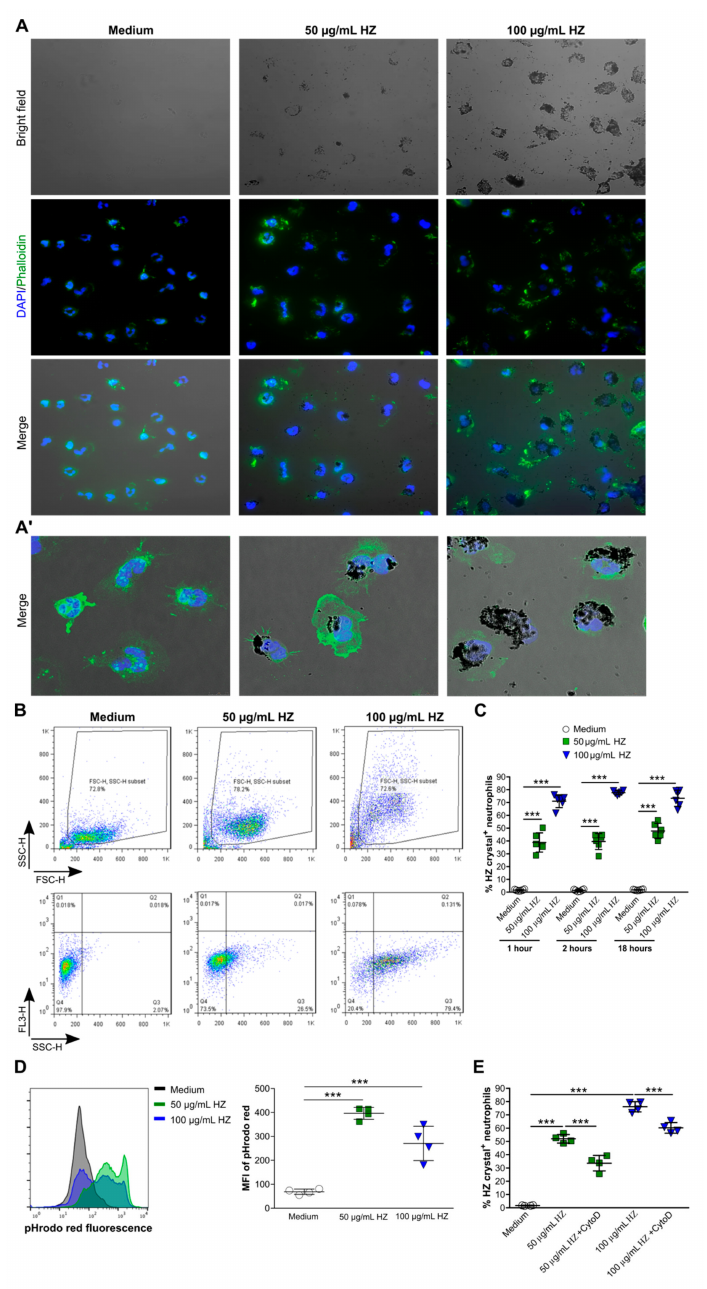
Figure1. Neutrophilsphagocytoselargeamountsofhemozoin(HZ)crystals. Humanbloodneutrophils were isolated from healthy volunteers and cultured in the presence or absence of hemozoin (HZ,